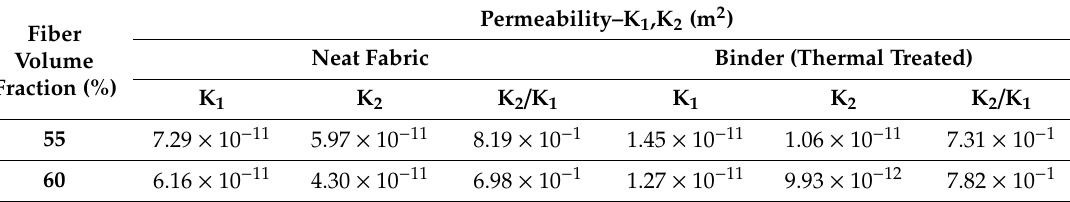
Figure 6. Change in the permeability in the in-plane direction according to the binder treatment. Table 2. The permeability of the fabric preform in the in-plane direction.